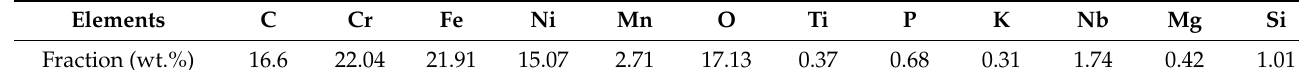
Figure 6. Elemental distribution in fracture morphology. Table 6. EDS results in fracture morphology.